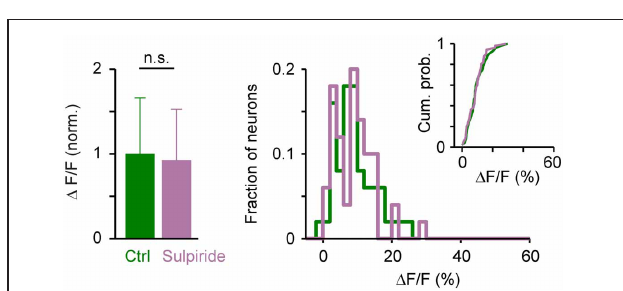
FIGURE 7 | Effects of DA on population activity patterns in Dp evoked by electrical stimulation of the olfactory tract. (A) Time-averaged spatial patterns of calcium signals evoked by olfactory tract stimulation (20Hz for 1s) before, during and after bath-application of DA, measured by multiphoton microscopy. (B) Calcium signals of all cells ( n = 380) before ( x -axis) and during ( y -axis) exposure to DA. Gray: line with slope 1. r, Pearson correlation coefficient. (C) Left: Calcium signals of 50 randomly selected neurons as a function of time, sorted by magnitude in the